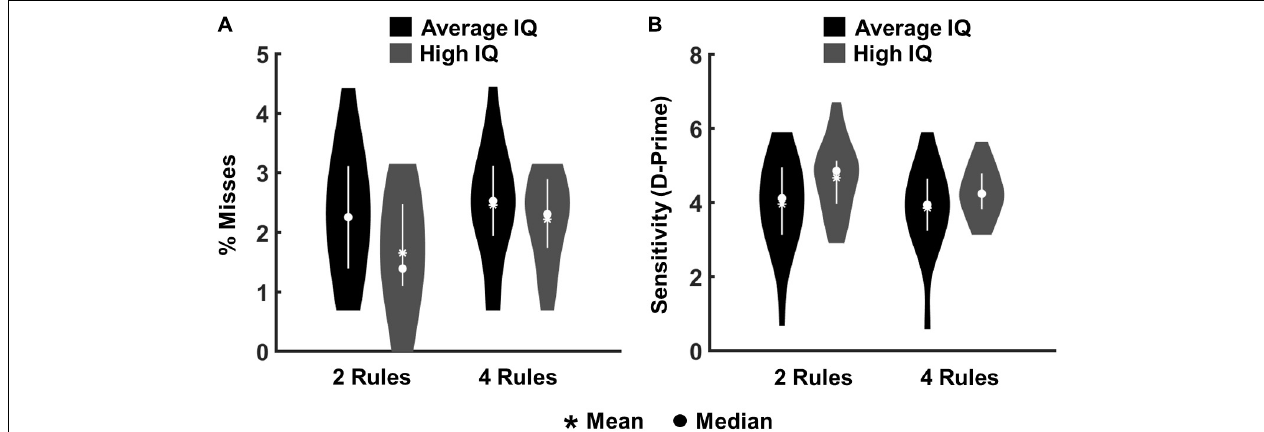
FIGURE 2 | Behavioural results from the eight main chunks of all experimental runs for high-IQ and average-IQ participants. (A) Percentages of misses for targets. (B) Sensitivity index (d-prime) reflecting the proportion of correct responses (hits) in relation to false alarms.